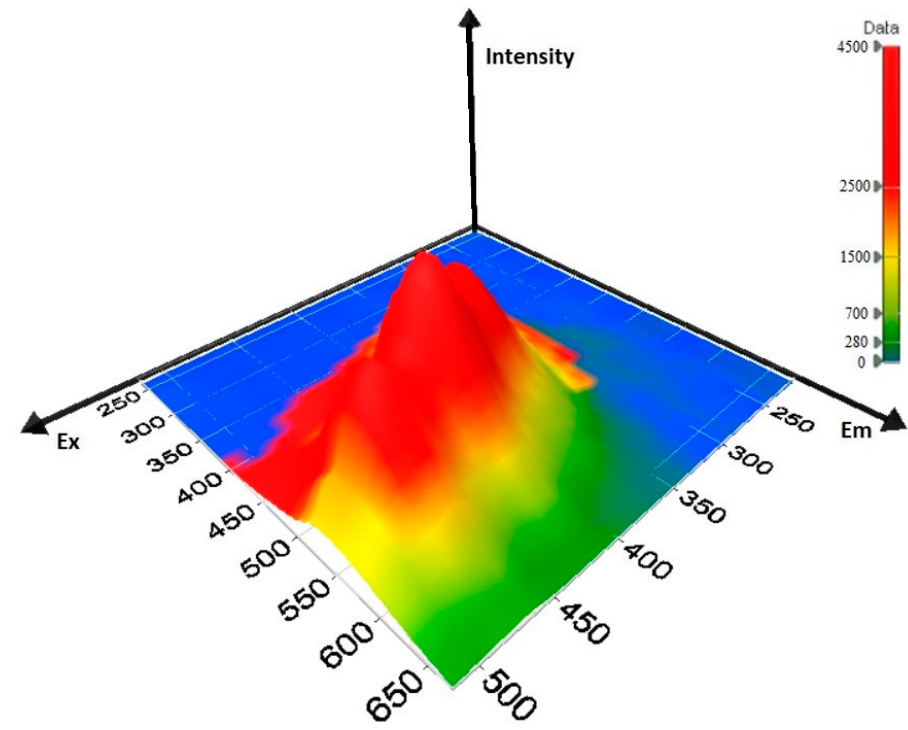
3 Figure 4. Characteristic 3D-EEM spectra of citrus